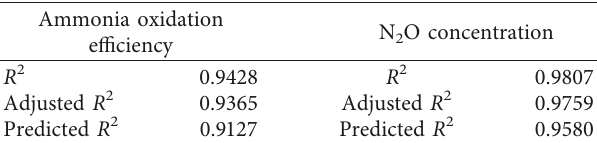
Table 10: The comparison between adjustment coefficients for two response surfaces.